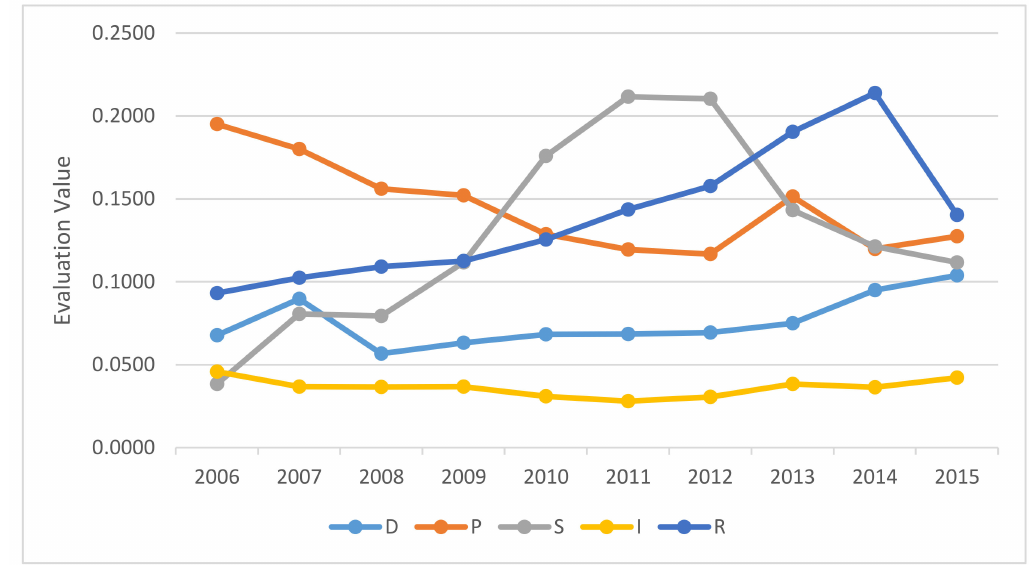
Figure 8. Evaluation values for the security in the five rare earth subsystems from